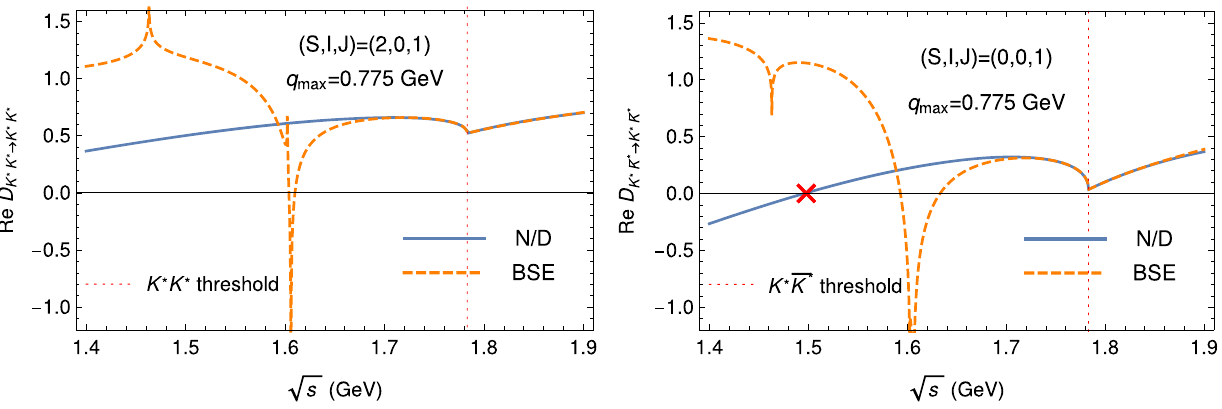
Fig. 7 Real parts of the D ( s ) functions for the ( 0 , 0 , 1 ) and ( 2 , 0 , 1 ) cases based on the N / D method and the on-shell factorization for the BSE. The pole due to the left-hand cut is absent for ( 2 , 0 , 1 ) , and is